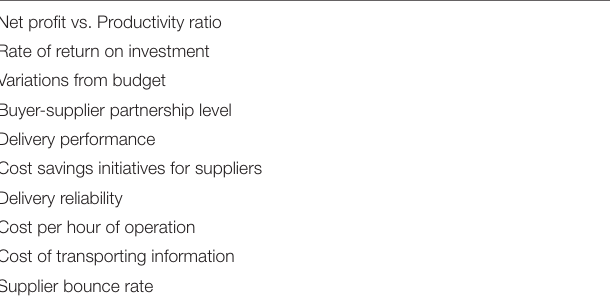
TABLE 4 | Performance metrics for the financial perspective.